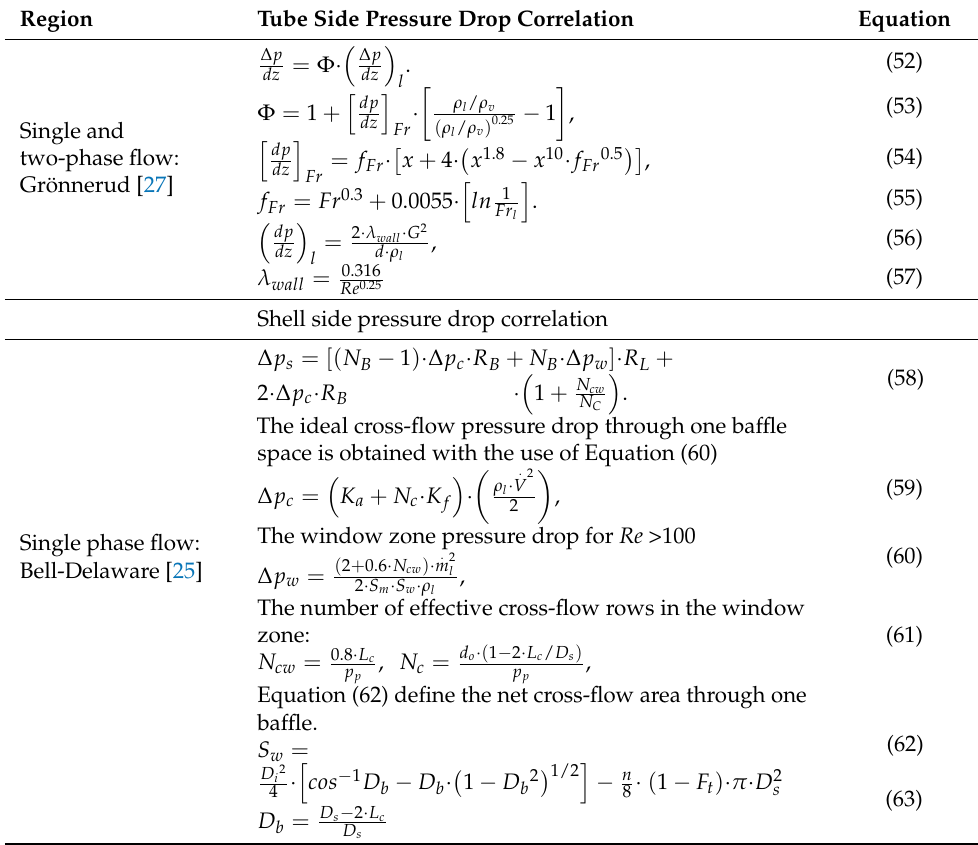
Table 2. Pressure drops